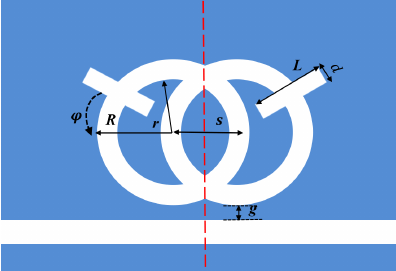
Figure 3. Single SRRDR.